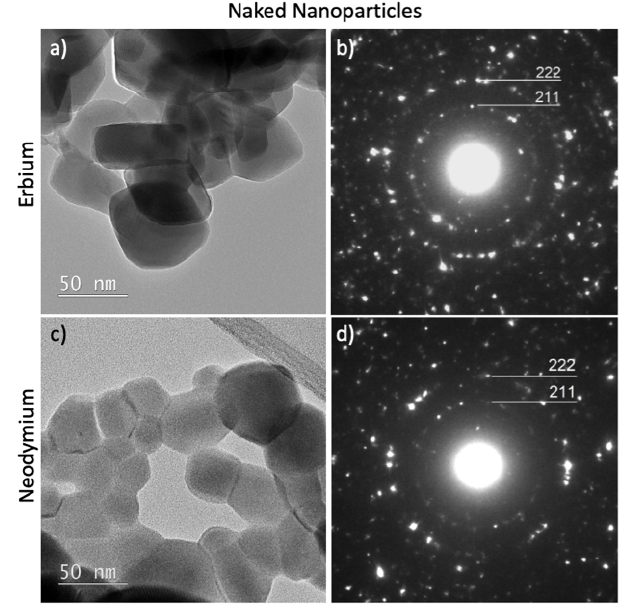
Figure 2. TEM micrographs and related diffraction patterns: ( a , b ) for sample E3 and ( c ) and ( d ) for sample N1.